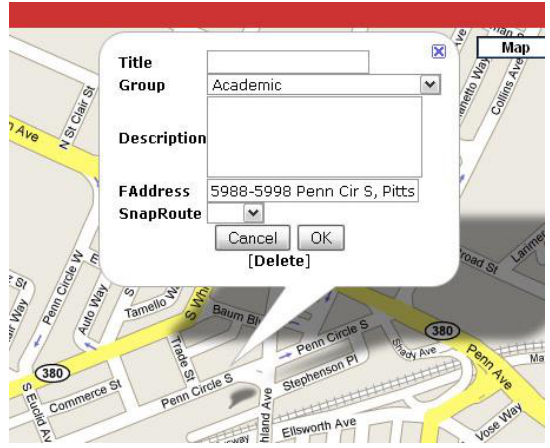
Figure 4. Example AOI selection and annotation in SoNavNet. Table 2. Principal differences between the